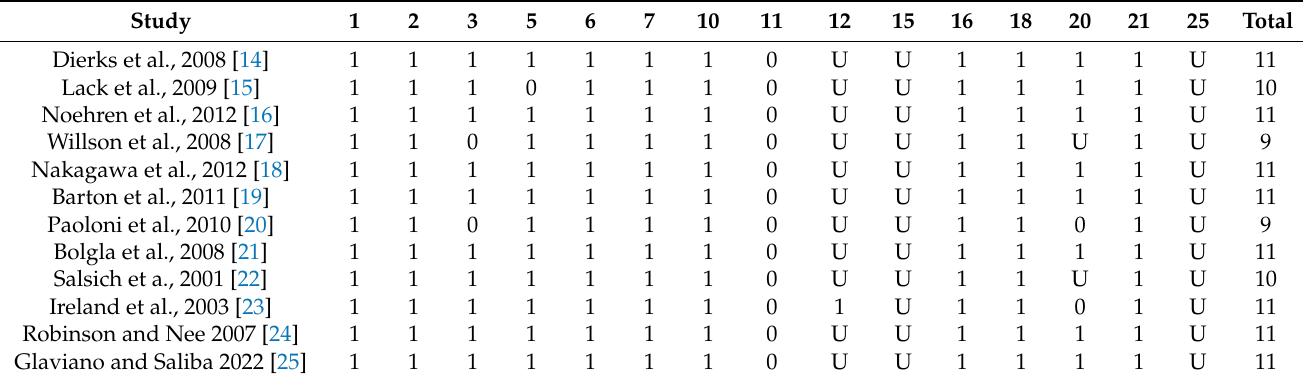
Table 1. Quality assessment of included studies.